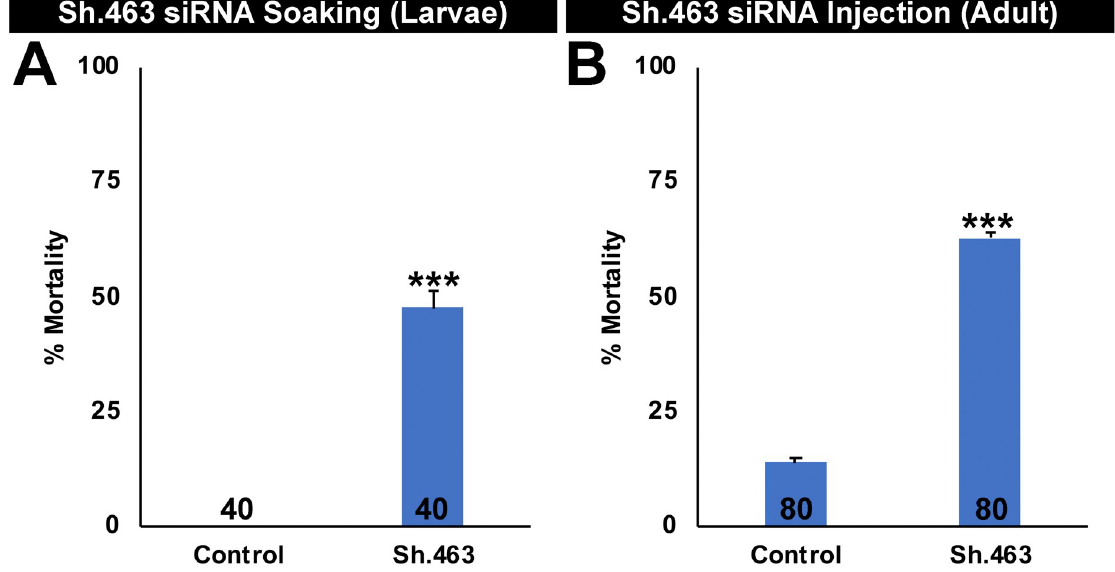
Fig 1. Sh.463 siRNA has larvicidal and adulticidal activity in A . aegypti . Significant larval mortality was observed after L1 larvae were soaked in 0.5 ug/ul Sh.463 siRNA (A). Significant adult mortality was observed after adult females were injected with 250 nl of 9 μ g/ μ l Sh.463 siRNA (B). Data from Sh.463 vs. control siRNA-treated mosquitoes are represented here as mean percentage mortality; ��� = P < 0.001; error bars denote standard errors of the mean (SEM). The samples sizes for each treatment are noted on the columns in each graph in this figure and in all subsequent